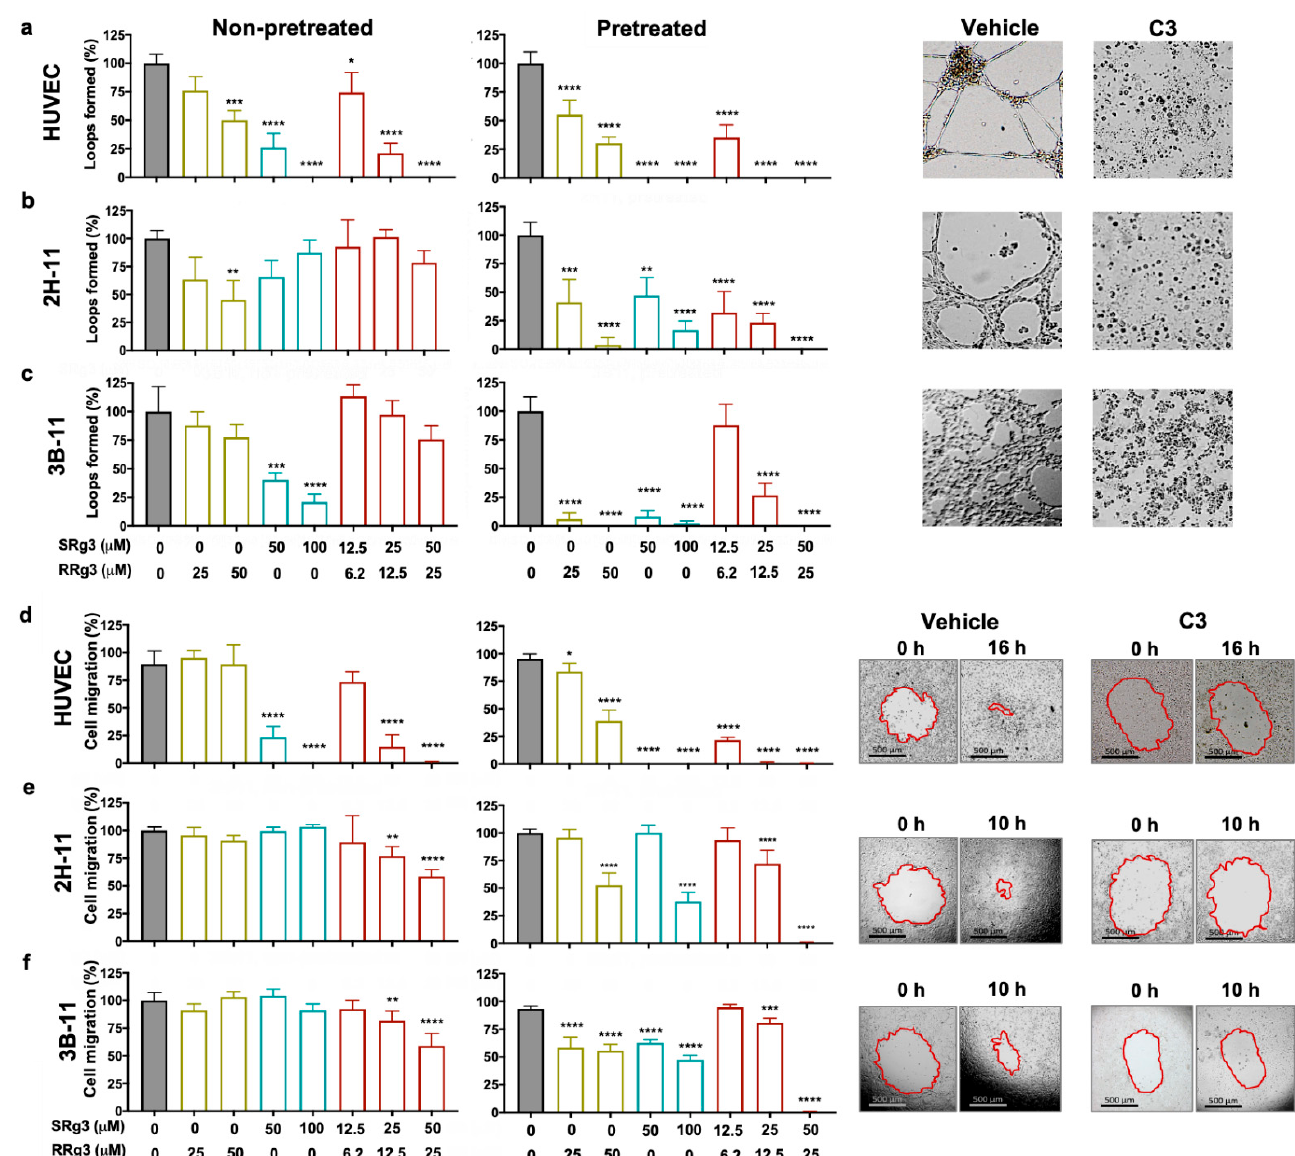
Figure 2. Effect of Rg3 epimers on loop formation ( a – c ) and migration ( d – f ) of human umbilical vein endothelial cell (HUVEC), 2H-11, and 3B-11 cells. Analysis of the loop formation and migration was performed at two timepoints; non- pretreated cells and 3-day pre-treated cells. Treatments are shown on the x axis, and ( a – c ) show the results of the loop formation in the HUVEC, 2H-11, and 3B-11 cell lines, respectively, at peak loop formation timepoints—16 h for HUVEC and 4 h for 2H-11 and 3B-11 cells. The experiments were done in triplicate and the results are presented as mean ± standard deviation (SD; p < 0.05). ( d – f ) show the results of cell migration in HUVEC, 2H-11 and 3B-11 cell lines, respectively. Results are presented as mean ± SD of 3 and 6 replicates for loop formation and migration assays, respectively ( p < 0.05). The images represent the pre-treated cells. C3 represents a combination of 50 µM SRg3 + 25 µM RRg3. * p < 0.05, ** p < 0.01, *** p < 0.001 and **** p < 0.0001.